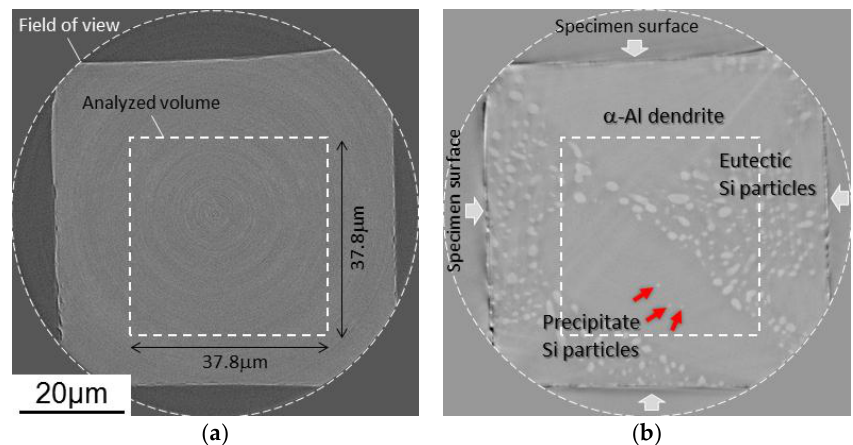
Figure 3. Slice images of nanotomography in Al-10.1%Si-4ppmP-108ppmSr cast alloy heat-treated at 773 K for 7.2 ks. The same slices are shown by ( a ) absorption contrast and ( b ) phase contrast. Field of view and analyze-volume position are indicated by white dashed-line circle and box. Eutectic Si-particles and precipitate Si-particles can be recognized as white objects in ( b ), though specimen surface only can be seen in ( a ).